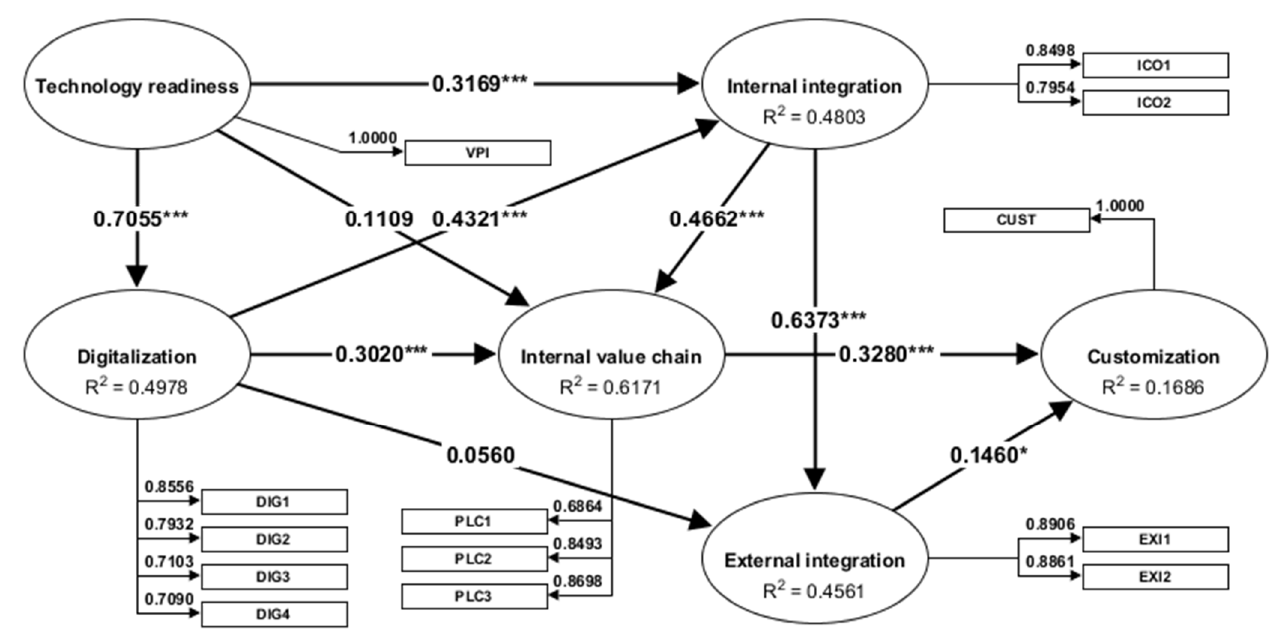
Figure 2. Results of the structural model. Note: significance is measured by one-tailed t test (* p -value < 0.05, *** p -value < 0.001).